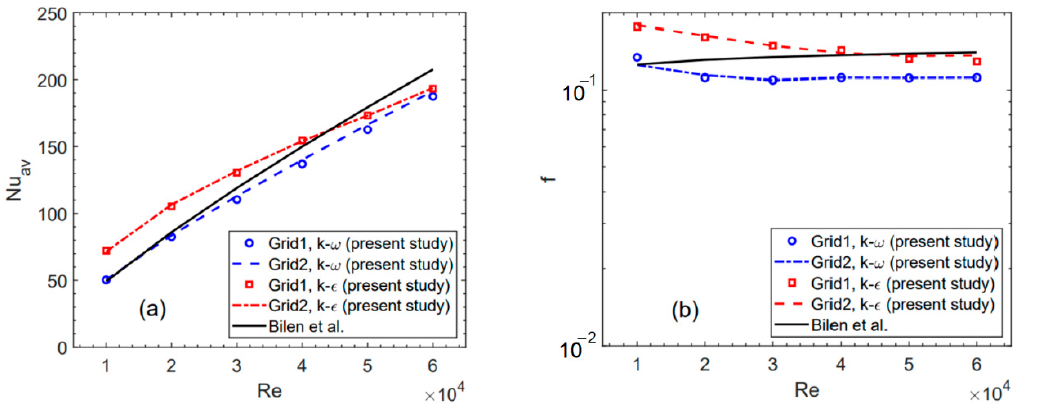
Figure 5. Verification of the present study of a ribbed tube at e/d = 0.1, p/d = 1.0, and w/d = 0.05: ( a ) Nusselt number at Pr = 0.71 and ( b ) friction factor.